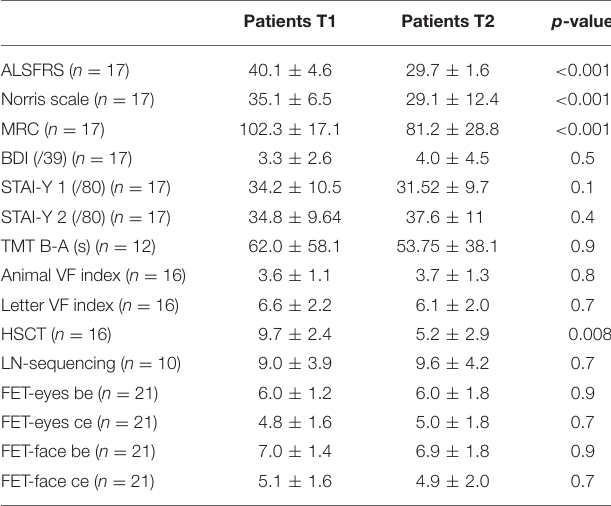
TABLE 4 | Changes in cortical thickness in patients at baseline (compared to TABLE 3 | Changes in neurological, psychological and cognitive scores of controls) and at follow-up (compared to baseline). patients with ALS evaluated at baseline and follow-up. Patients T1 Patients T2 p -value At baseline At follow-up